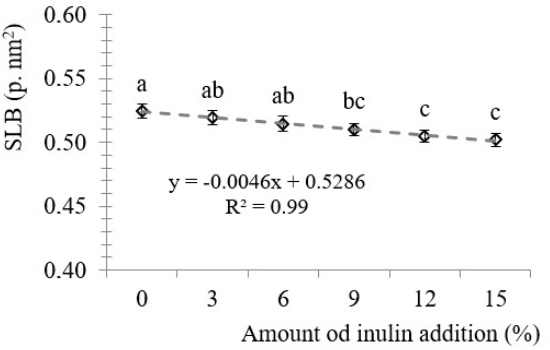
Figure 5. Solid-liquid balance (SLB) of yogurts with 0%, 3%, 6%, 9%, 12% or 15% w/w inulin addition (a, b, c…—various letters for average values mean statistically significant differences, p < 0.05).